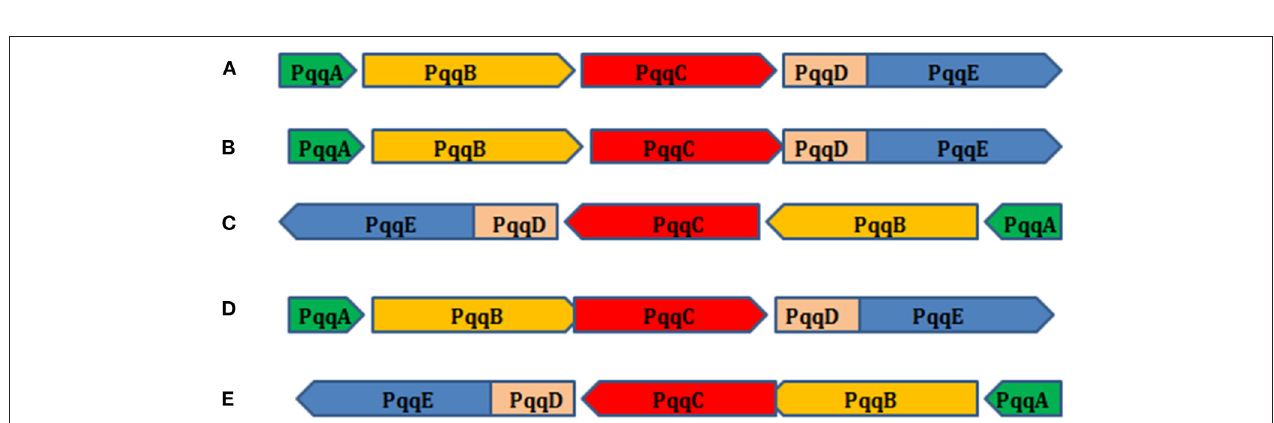
FIGURE 8 | Gene organization of the pqqA (A) , pqqB (B) , pqqC (C) , pqqD (D) , and pqqE (E) genes in the PQQ operon of selected Gammaproteobacteria. The right arrow indicates a positive strand, and the left arrow indicates a negative strand.